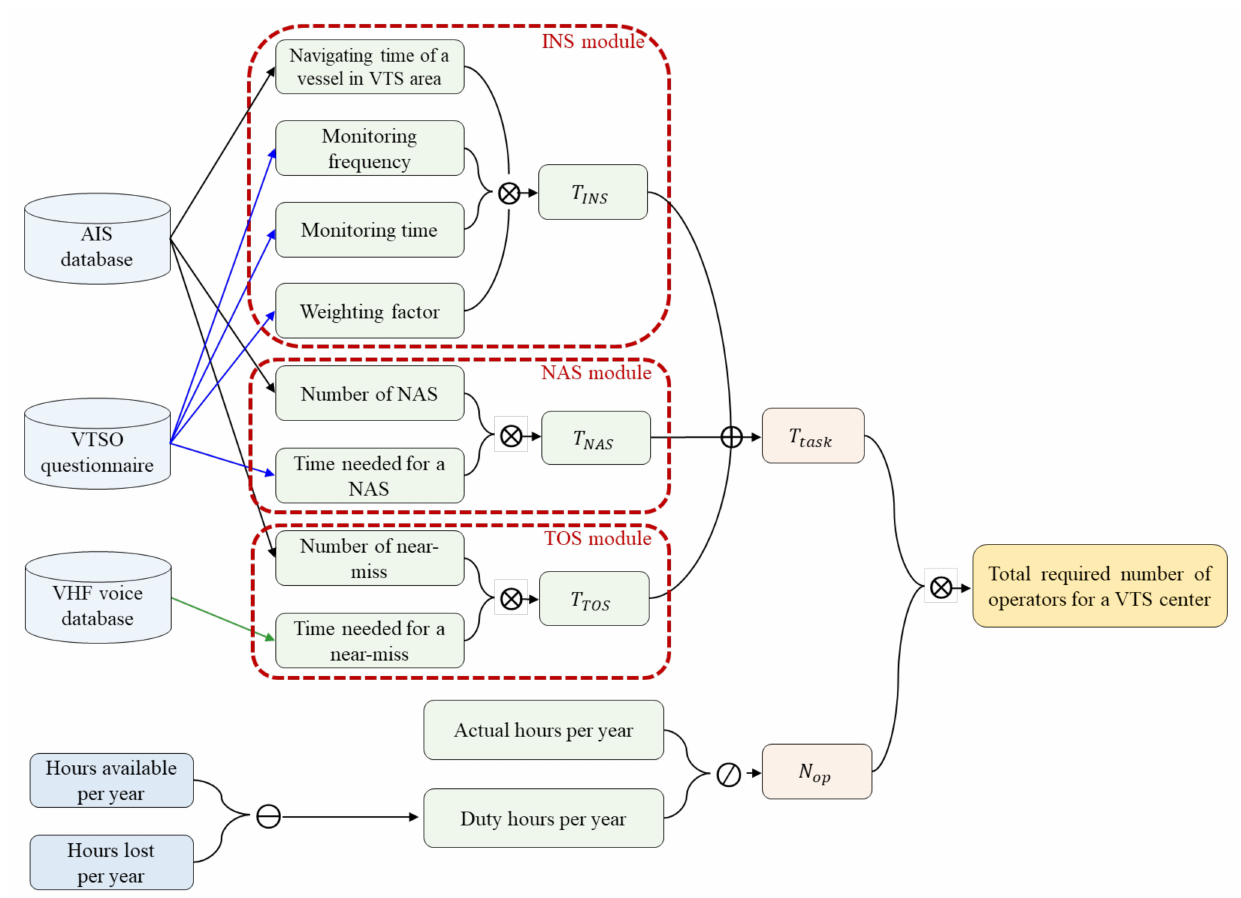
Figure 1. Optimal VTS staffing model process